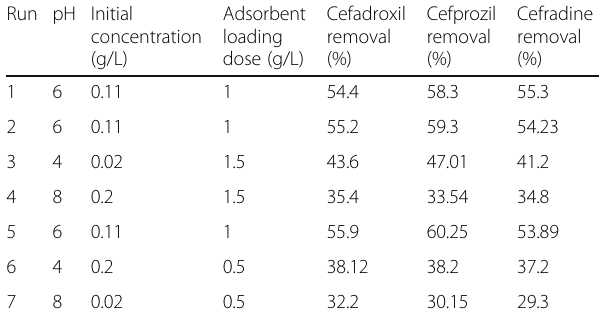
Table 5 Factorial design for experiments employed for cephalosporins adsorption and results obtained using HPLC-UV